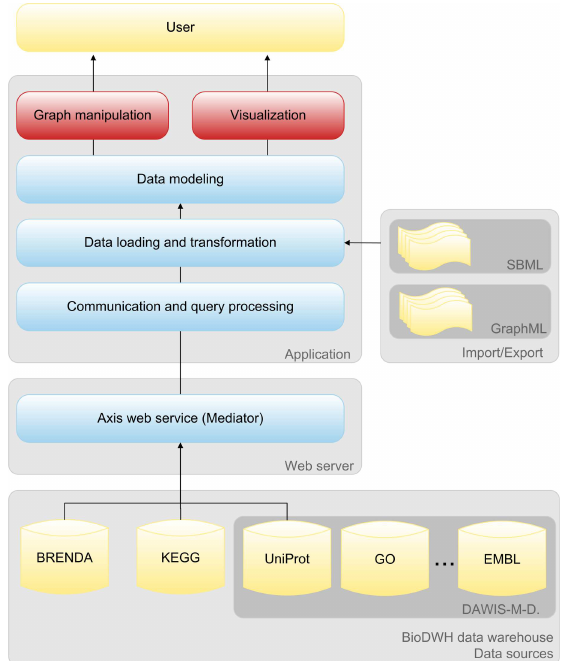
Figure 3: Schematic representation of the VANESA 3-layer system